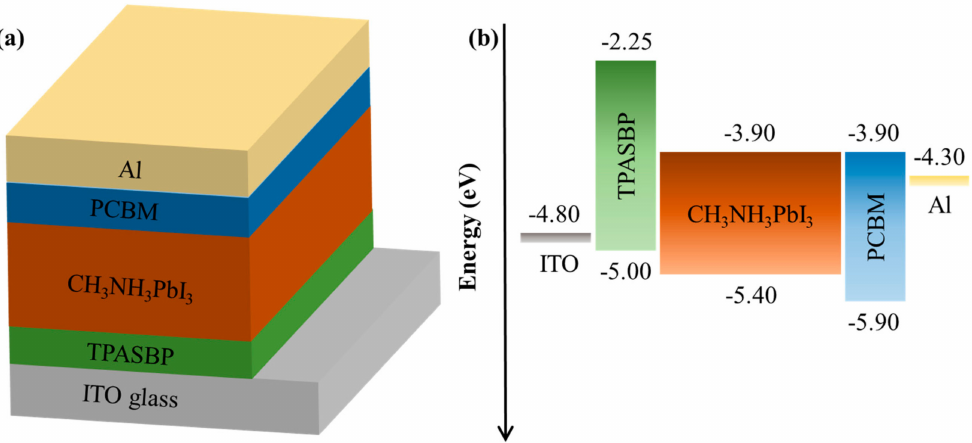
Figure 5. ( a ) Schematic device structure of the inverted PSCs constructed by ITO / TPASBP / CH 3 NH 3 PbI 3 / PCBM / Al, ( b ) schematic energy level diagram of each layer.